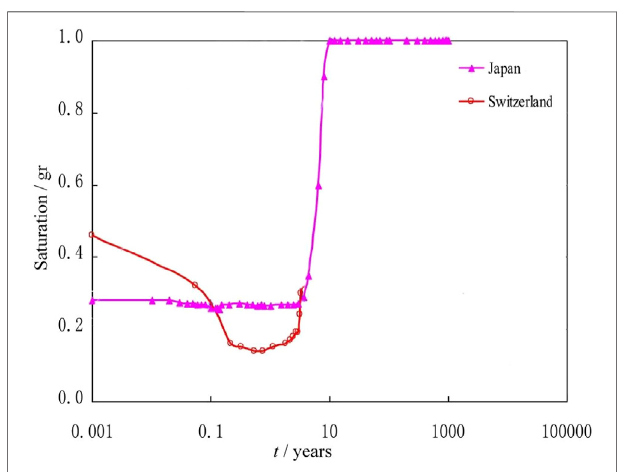
FIGURE3| ModelofbuffermaterialsaturationfortheHLNWcontainerin short and long terms.